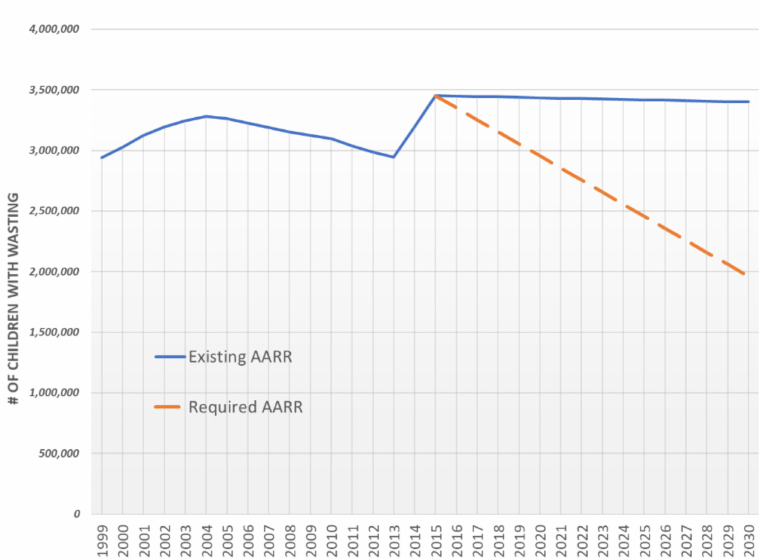
Figure 1. Trends and estimates of the number of wasted children 6–59 months (1999–2030) (note: AARR, annual reduction rate; projections were made using the actual and “required” AARR, but given that wasting is an acute condition that can change rapidly and frequently, this may not be necessarily accurate).